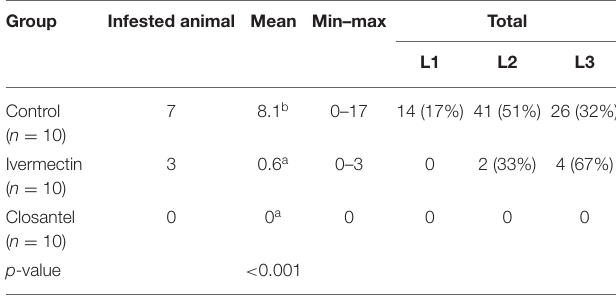
TABLE 2 | First (L1), second (L2) and third stage (L3) larvae of Oestrus ovis in naturally infested lambs of the control, ivermectin and closantel groups. Group Infested animal Mean